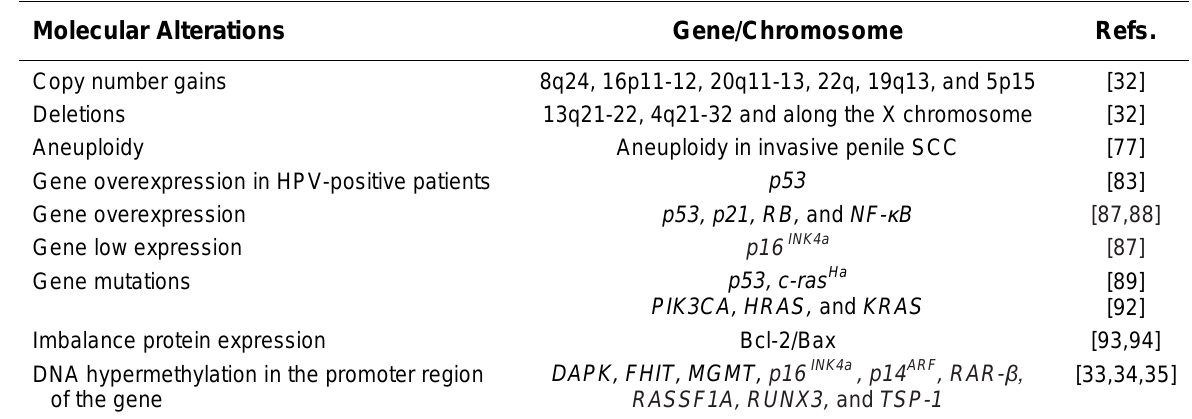
Molecular Alterations Observed in Penile